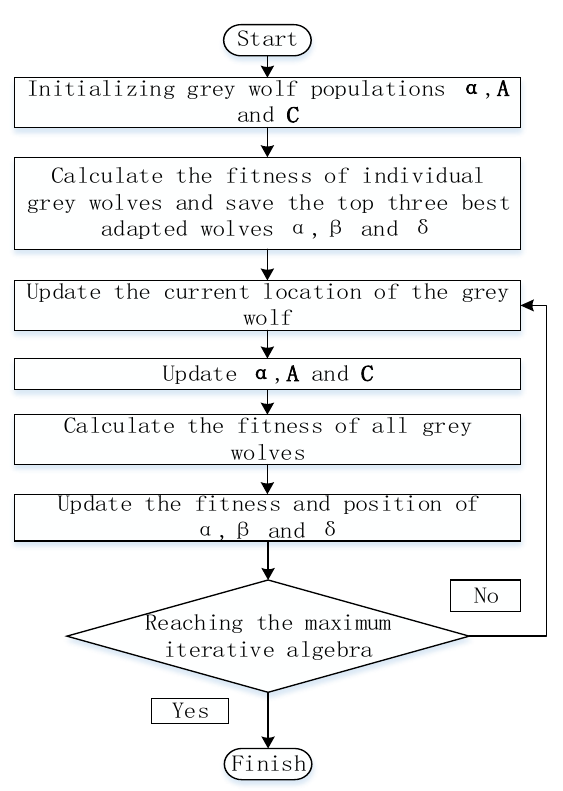
  t X is the current P